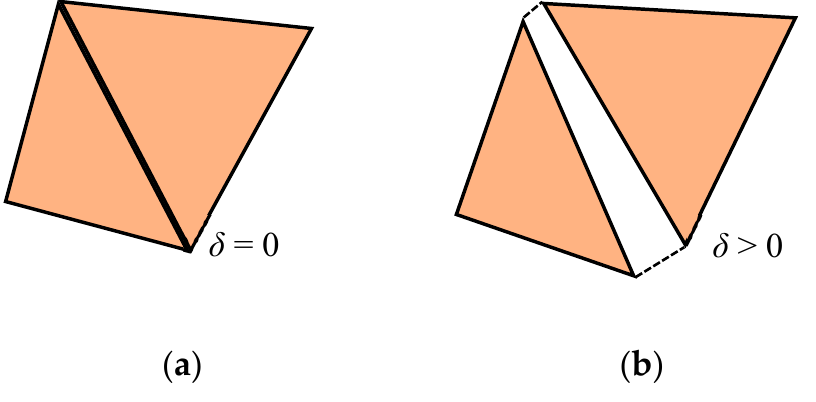
Figure 3. Element interface: ( a ) δ = 0; ( b ) δ > 0.